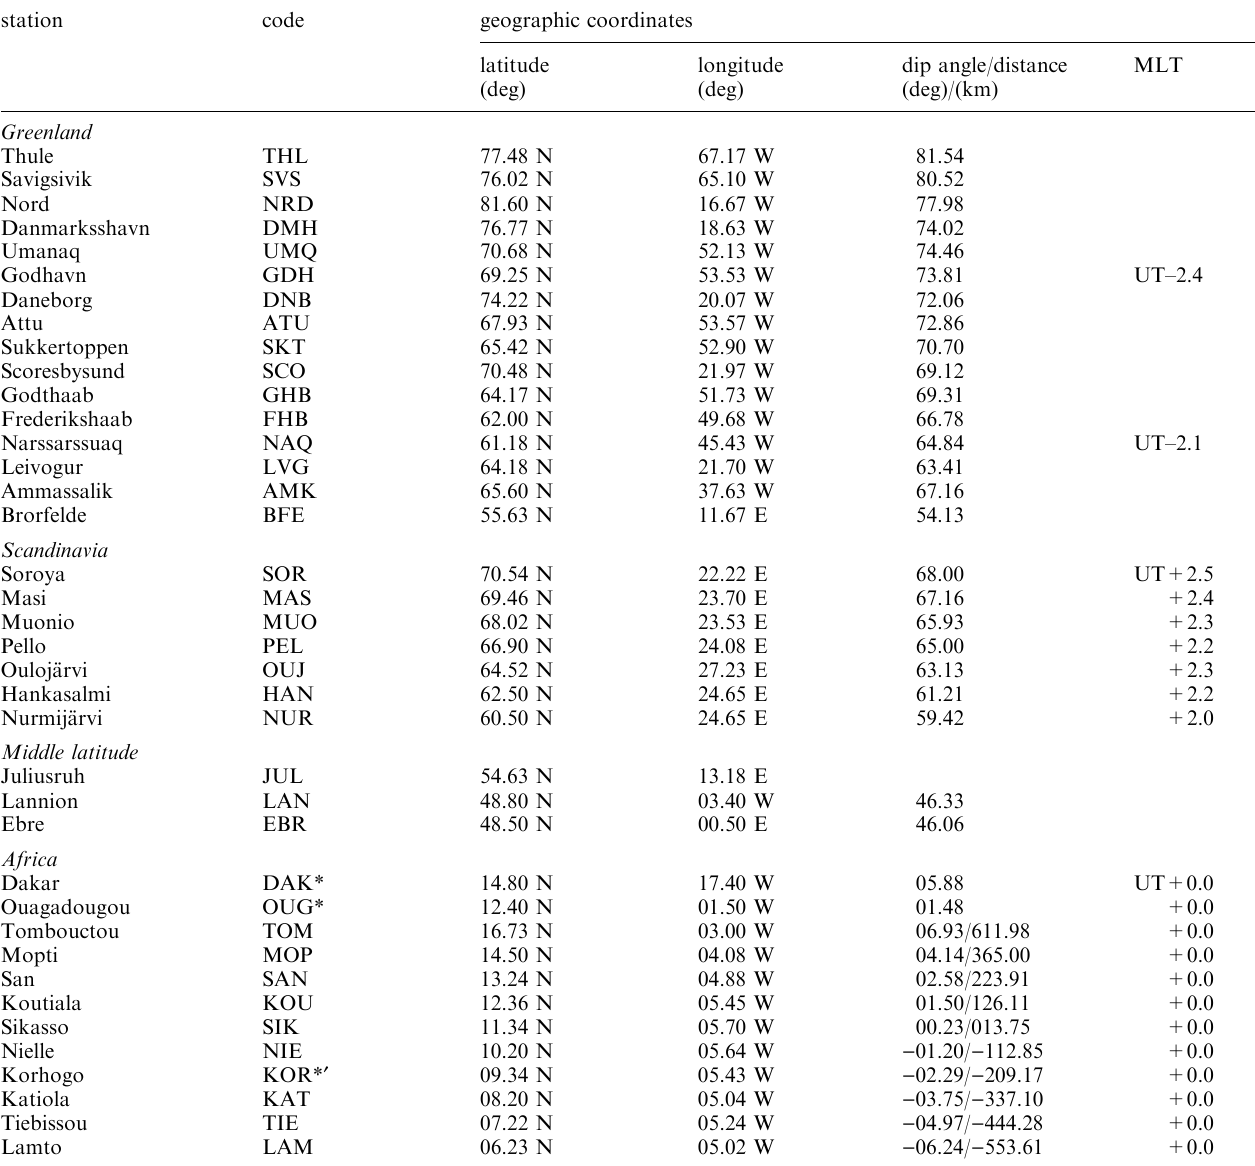
latitude longitude